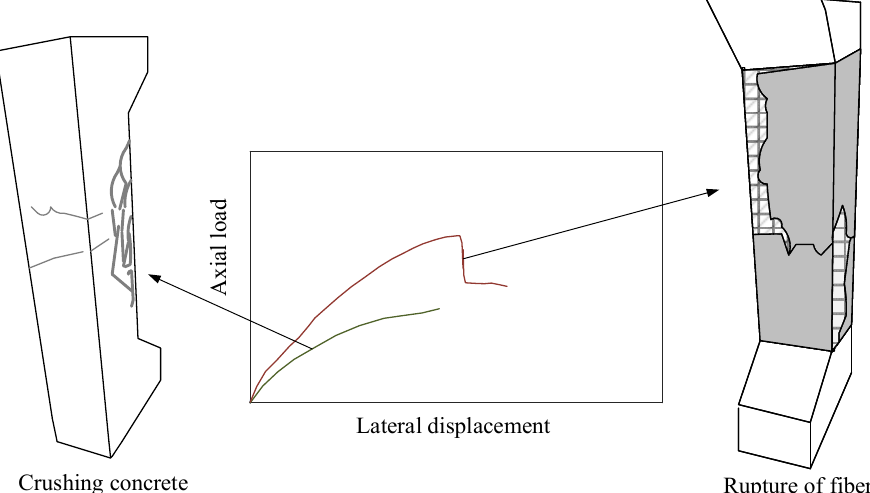
Figure 14. The effectiveness of different parameters on the load-deflection curves in terms of repaired and unrepaired columns.